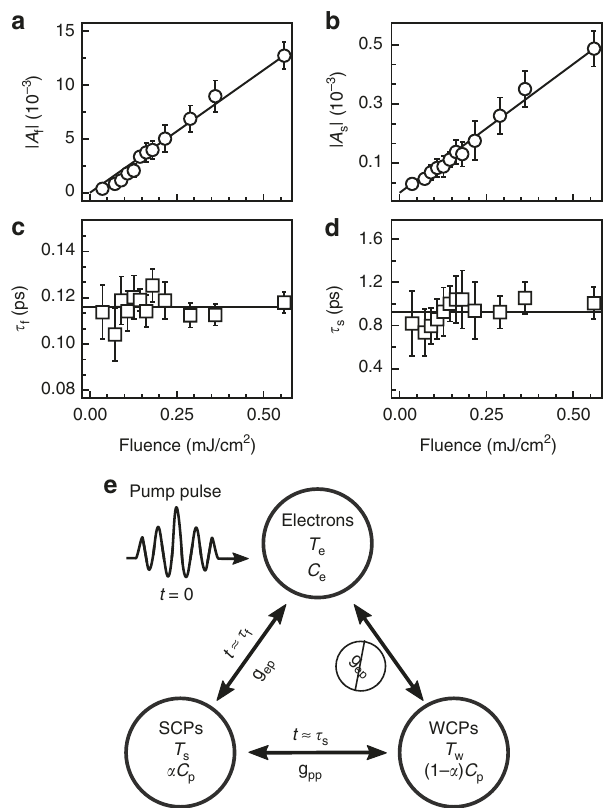
Fig. 3 Microscopic origin of the two relaxations in LiOsO 3 . a – d Fluence dependence of the transient re fl ectivity of LiOsO 3 at T = 80 K as captured by the parameters of the bi-exponential model. Both the amplitudes of a fast and b slow relaxation processes display a linear dependence that is characteristic of the linear response regime. However, the decay constants of a fast and b slow relaxation processes display a lack of fl uence dependence that is indicative of intra-band photo-carrier relaxation and therefore suggests a selective electron – phonon coupling in LiOsO 3 . Black lines in a – d are linear fi ts of the data while error bars derive from the χ 2 of the bi-exponential fi ts. e Schematic of microscopic origin of the relaxation processes of LiOsO 3 . Electrons, initially excited to a high effective temperature T e by the pump pulse, relax on the time scale τ f by thermalizing with only a set of strongly coupled phonons (SCPs) at temperature T s via electron – phonon coupling g ep . The SCPs then relax on a time scale τ s by thermalizing with the rest of the lattice modes, referred to as the weakly coupled phonons (WCPs) at temperature T w , via phonon – phonon coupling g pp . The relative heat capacities of the two phononic thermal baths are found by partitioning the total lattice heat capacity C p by the parameter